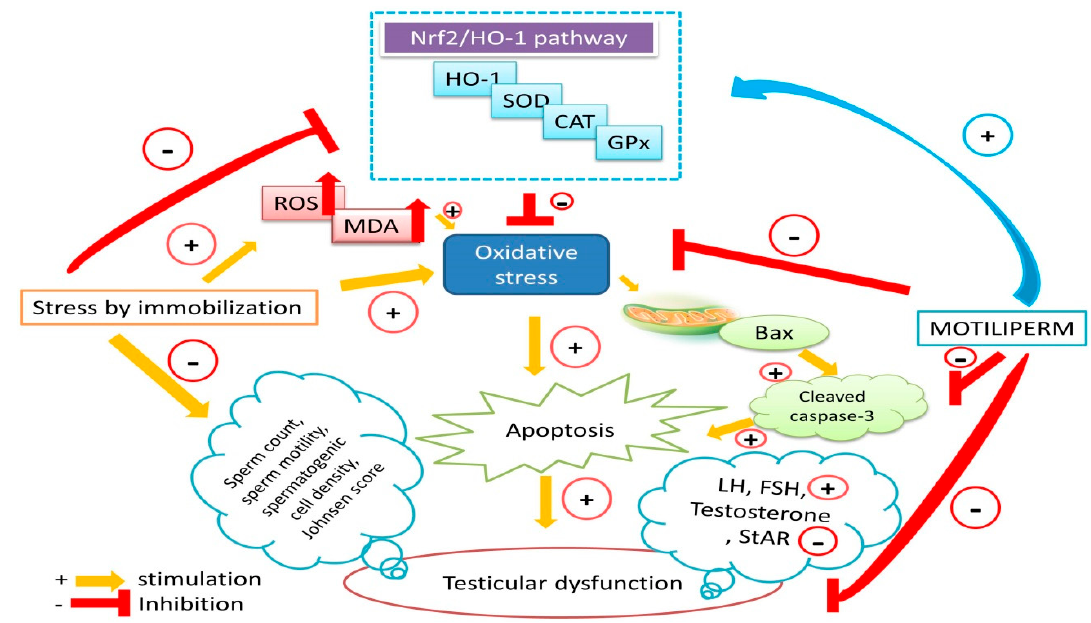
Figure 4. Schematic diagram of the therapeutic effect of MOTILIPERM against immobilization stress-induced testicular dysfunction. Bax: BCL2 associated X protein; Nrf2: nuclear factor erythroid 2-related factor 2; HO-1: heme oxygenase 1; GPx: glutathione peroxidase; SOD: superoxide dismutase; CAT: catalase; ROS: reactive oxygen species; MDA: malonaldehyde; LH: luteinizing hormone; FSH: follicle stimulating hormone.